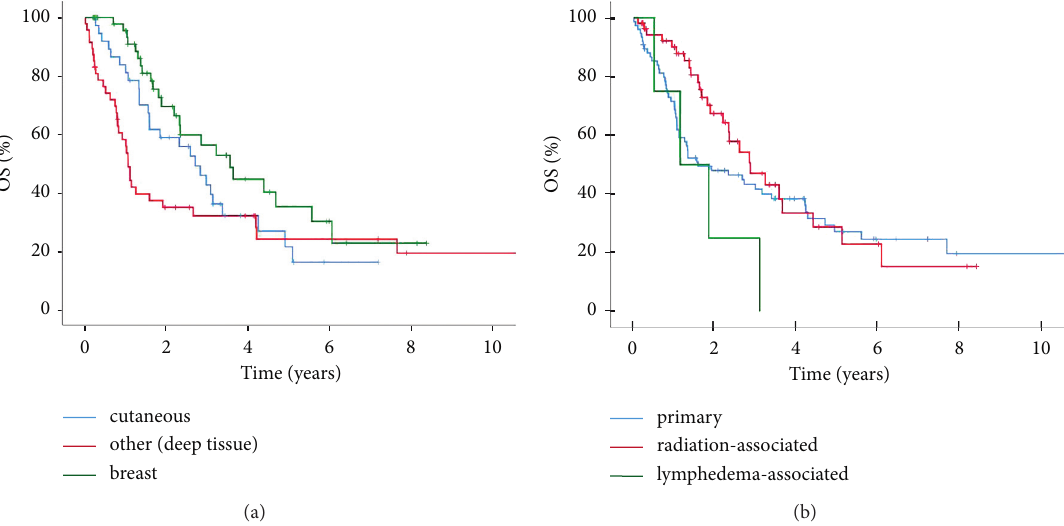
Figure 1: Overall survival (OS). Kaplan–Meier curves showing 10-year OS (a) comparing deep soft tissue angiosarcomas ( N � 47), cu- taneous angiosarcomas ( N � 37), and angiosarcomas of the breast ( N � 52) with a median OS of 12.7 vs. 35.6 ( p � 0.213) and 42.6 months ( p � 0.006 ∗∗ ) and (b) comparing primary ( N � 76), radiation-associated ( N � 55), and lymphedema-associated ( N � 4) angiosarcomas with a median OS of 18.9, 34.2, and 13.6 months ( p > 0.05). Table 2: Univariate analysis for median overall survival, local recurrence-free survival, and metastasis-free survival displayed in months and p value.